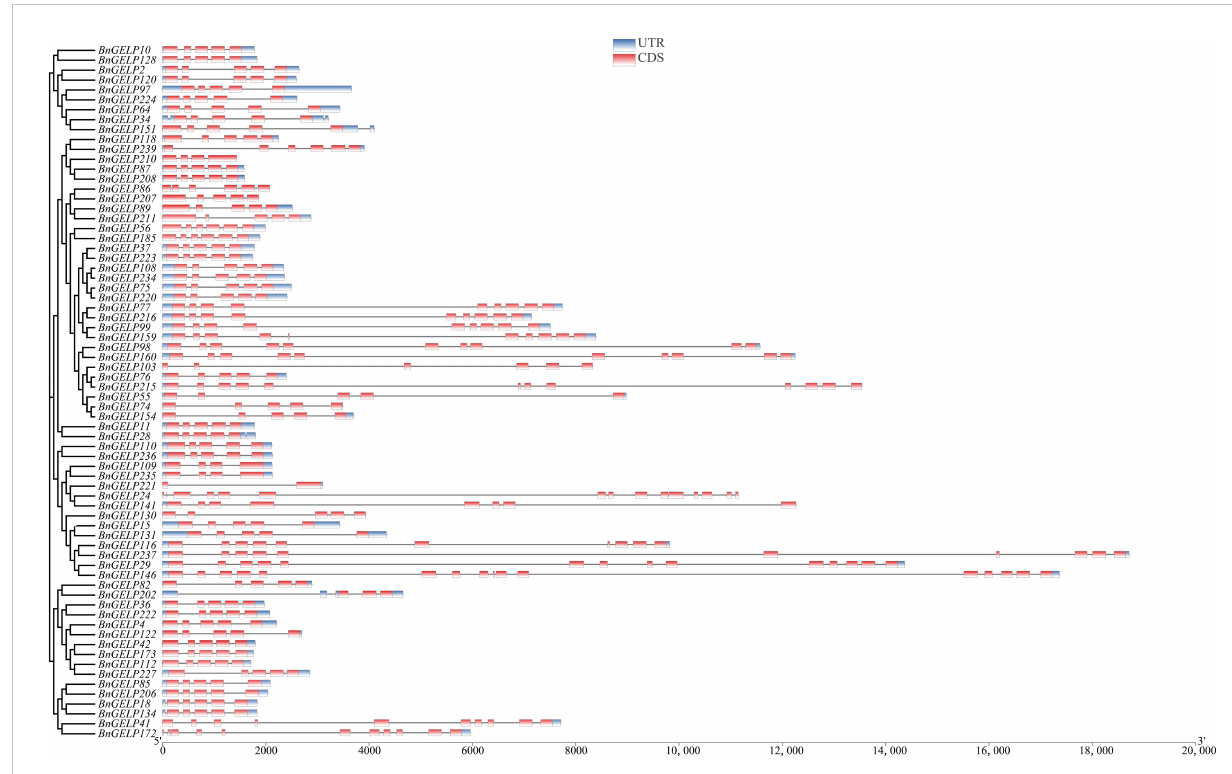
FIGURE 5 Schematic exon/intron structures of the clade 5 BnGELP genes. The red boxes represent exons and black lines represent introns. The UTR regions are indicated in blue boxes. The length of each CDS can be estimated by the scale at the